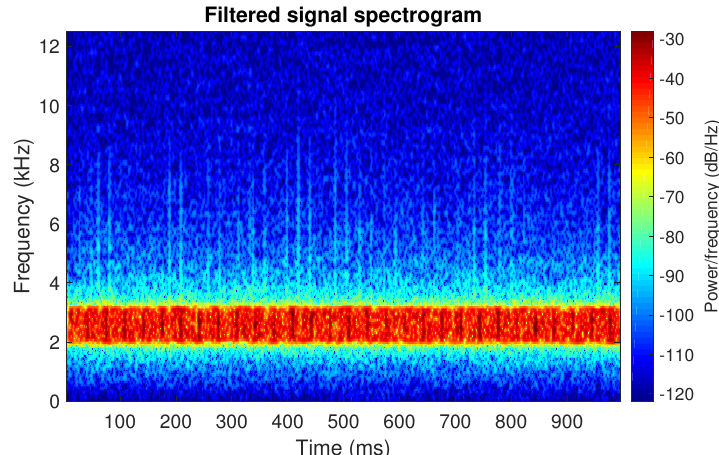
Figure 10. Spectrogram of filtered signal s 1 by Spearman selector.